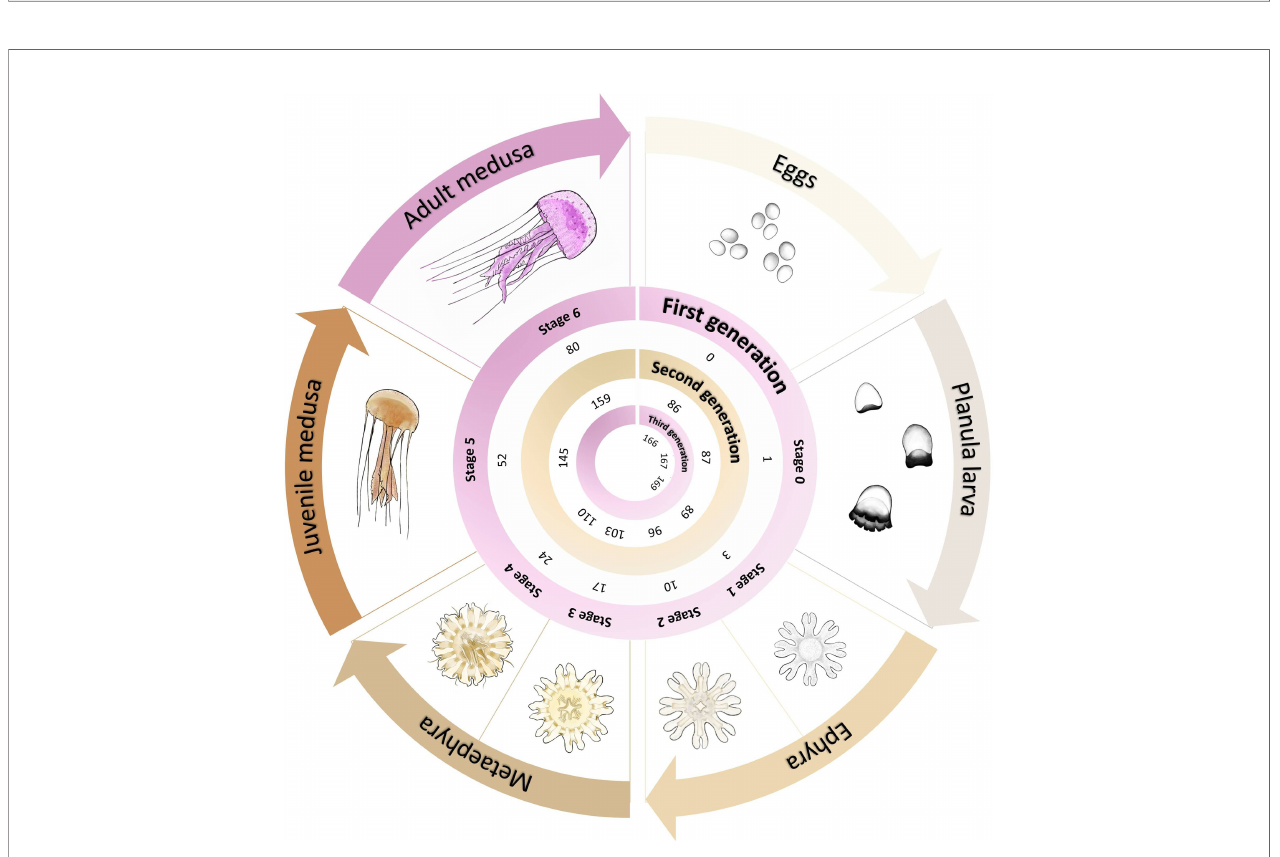
FIGURE 5 | Graphical representation of the Pelagia noctiluca life cycle optimization at 22°C. It includes the post-fecundation days until each stage of its life cycle is reached, when fed with the medusivorous diet (culture 3). Detailed morphological and cnidome descriptions for each life cycle stage can be consulted in Ballesteros et al. (2021b). Illustrations of the life cycle by Lau Lo ́